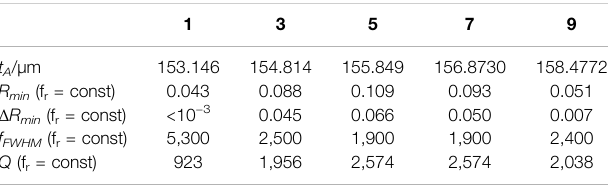
TABLE 2 | Characteristicvaluesofthe 1,3, 5,7, and 9PnC at aconstantresonant frequency of 4,891 kHz.